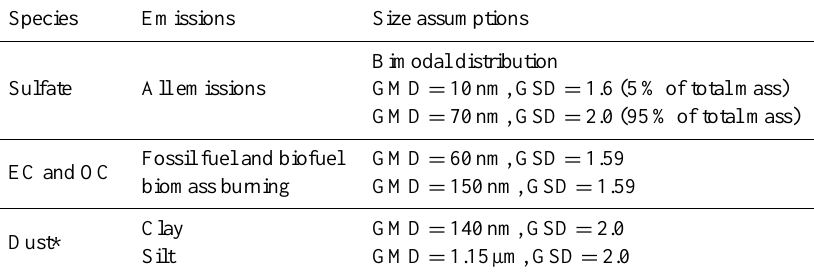
Table 2. Emission size distributions assumed in ModelE2-TOMAS. * This is the soil size assumption used in ModelE2-TOMAS, and the dust emission size distribution is additionally influenced by meteorological variables. GMD stands for geometric mean diameter, and GSD for geometric standard deviation.